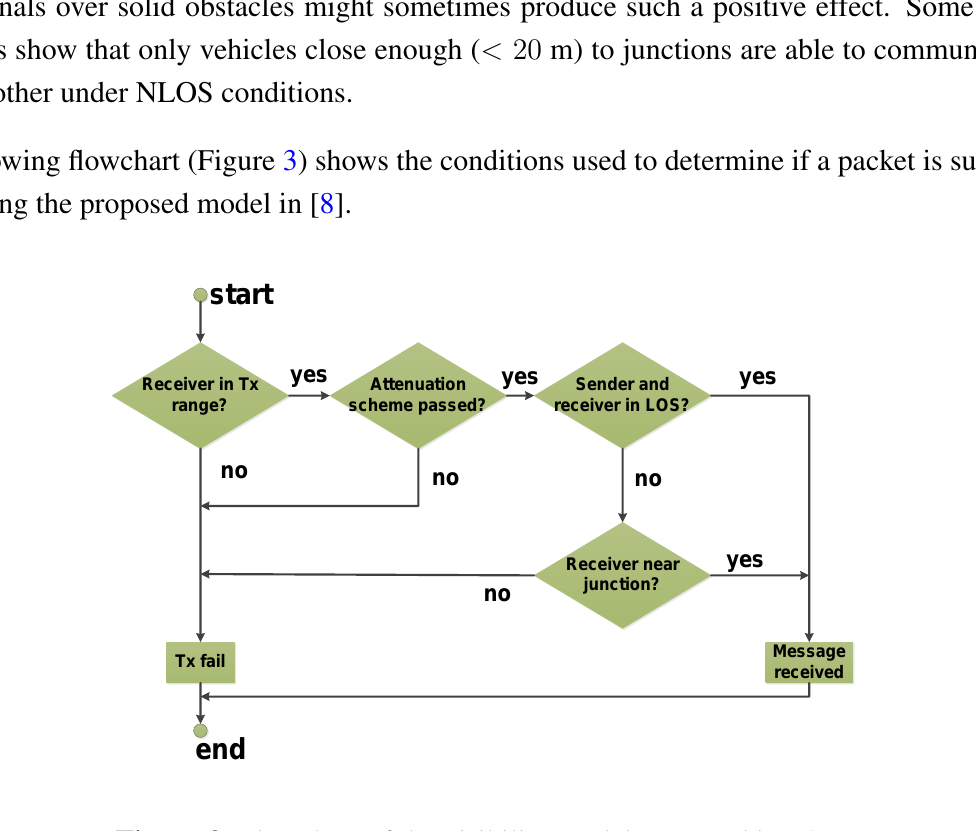
Figure 3. Flowchart of the visibility model proposed in